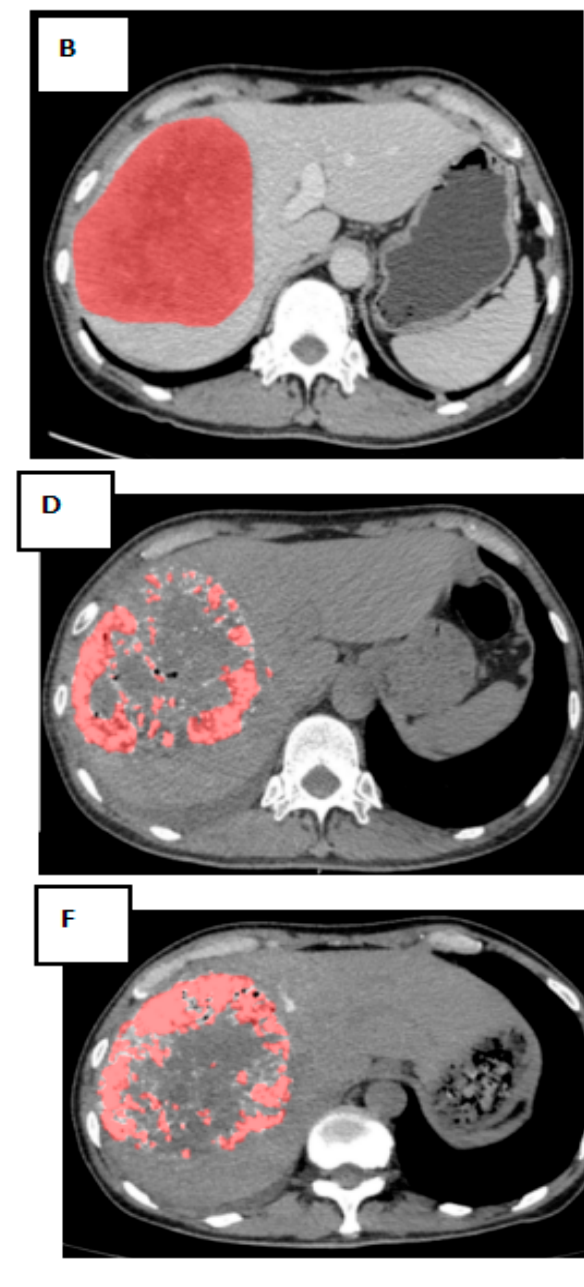
Figure 2. 3D volumetric semi-automatic evaluation of diffuse lipiodol retention from one representative patient. ( A ): A large HCC in right hepatic lobe (red arrow) seen on preprocedural contrast-enhanced CT images as a hypoattenuating tumor in the portal venous phase. ( B ): The red shaded area depicts semi-automated segmentation of the tumor; the tumor volume on the pretreatment MDCT was 512.6 cm 3 . ( C ): Lipiodol retention on noncontrast CT imaging in pre-TACE-2. ( D ): The red shaded area depicts the lipiodol volume on noncontrast CT imaging of 121.7 cm 3 in pre-TACE-2. ( E ): Lipiodol retention on noncontrast CT imaging in pre-TACE-3. ( F ): The red shaded area demonstrates the lipiodol volume on noncontrast CT imaging as 174.8 cm 3 in pre-TACE-3. After two cycles of TACEs, the volume of lipiodol was less than 50% of total tumor volume. TACE: transarterial chemoembolization; BCLC: Barcelona Clinic Liver Cancer; MDCT: multi-detector computed tomography; HCC: hepatocellular carcinoma.